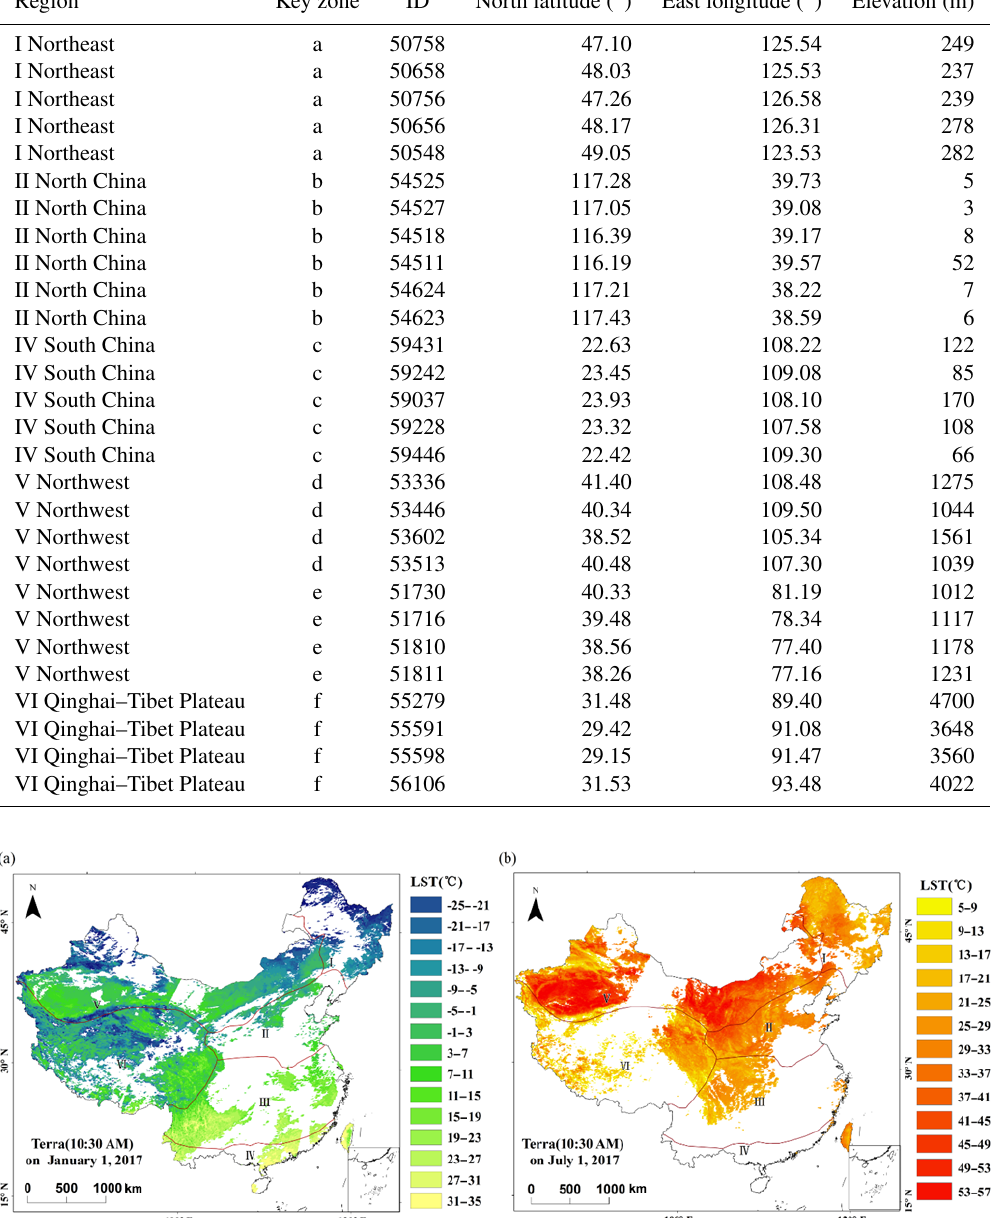
The spatial distribution pattern of invalid monthly Terra LST data after filtering by the QA layer is shown in Fig. 4. The low-quality pixel coverage rates for January and July 2017 were 23.45 % and 19.68 %, respectively. There